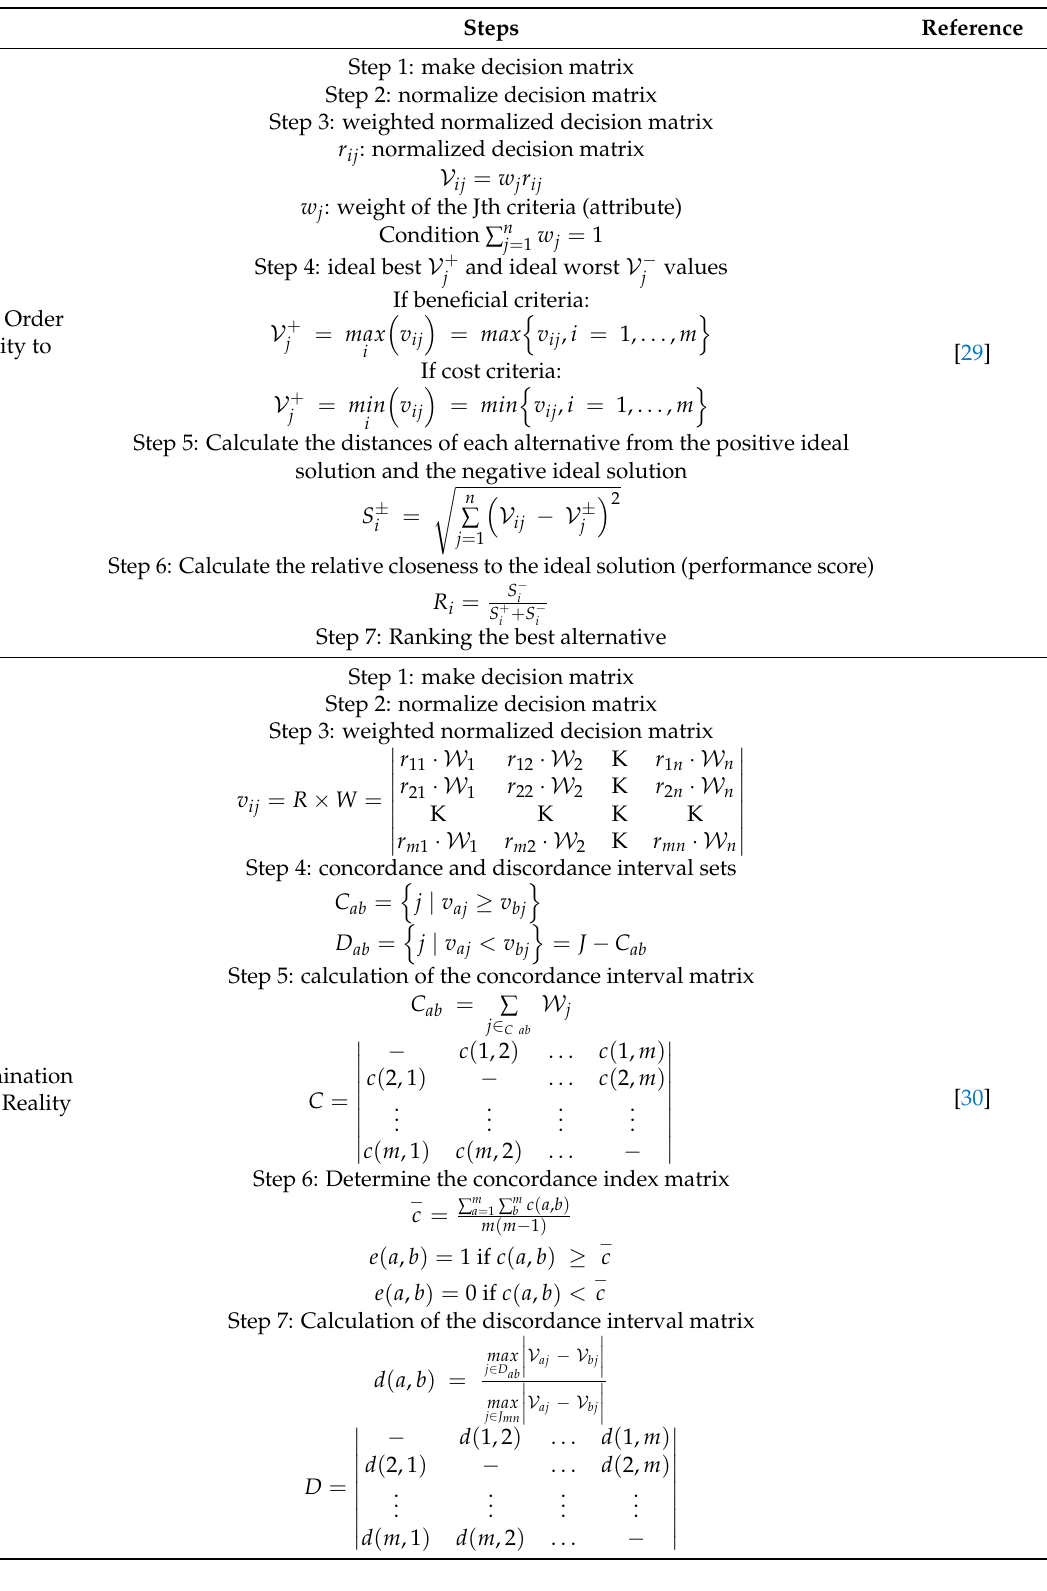
Table 1. Key equations of MCDMs used in this study. MCDM Steps Reference